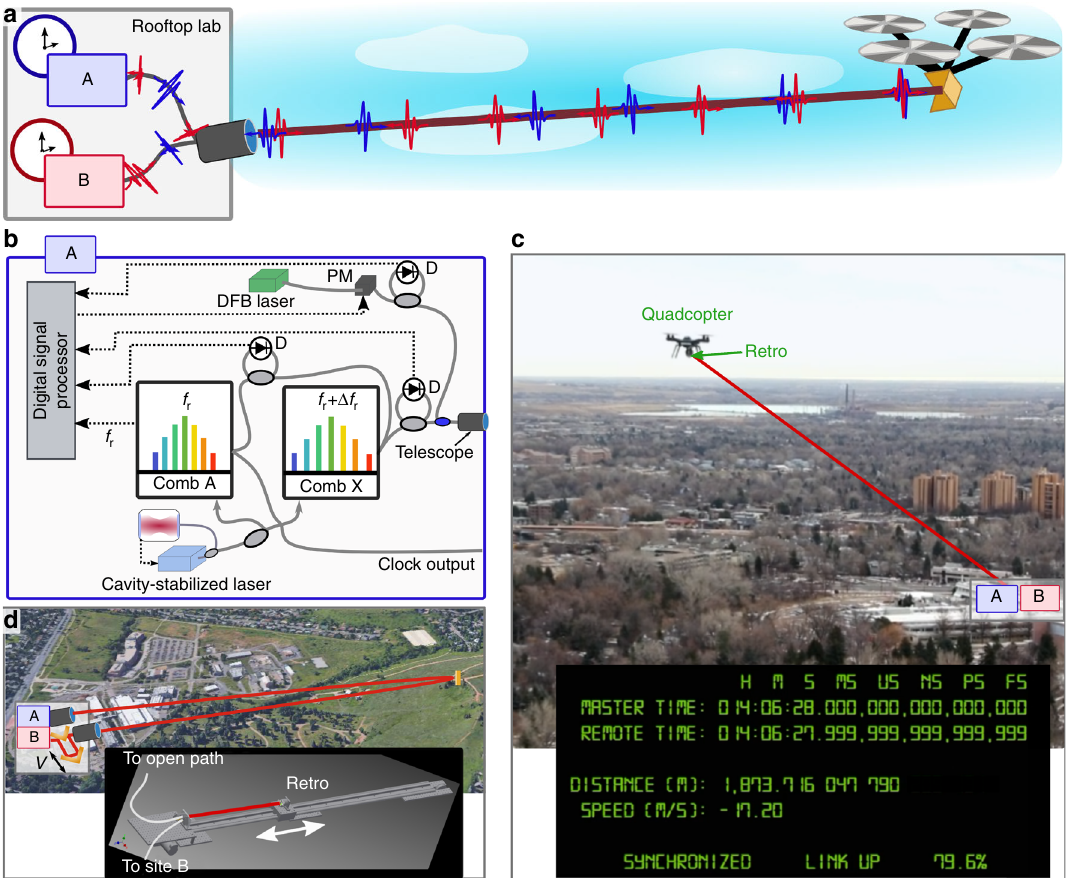
Fig. 1 Experimental con fi guration for O-TWTFT demonstration via a moving platform. a Two optical timescales are synchronized over a folded link to a moving quadcopter-mounted retrore fl ector. The light is polarization multiplexed between site A and site B, co-located in a rooftop laboratory, and directed over the air to the quadcopter by a tracking telescope. b Schematic of master site A consisting of the comb A with repetition rate f r , transfer comb X with repetition rate f r + Δ f r , a cavity-stabilized laser, a phase-modulated distributed feedback (DFB) laser to support the optical communication channel and a digital signal processor. Remote site B is identical except that it contains only the remote comb B. In addition, the digital signal processor at site B applies feedback to remote comb B to synchronize the two sites. Gray lines: optical fi ber; gray ovals: 50:50 couplers; blue oval: wavelength division multiplexer; D: balanced photodetector; dashed black lines: rf signals. c Images from Supplementary Movie 1. The real-time output includes the calculated times (from system turn-on), the round-trip propagation distance, the closing speed, and link status including the percentage of time without signal fades. d Additional experimental setup to synchronize the two sites over a 0 – 4 km free-space path to a fi xed retrore fl ector and including an in-line 6-pass swept delay line that mimics high closing velocities (see